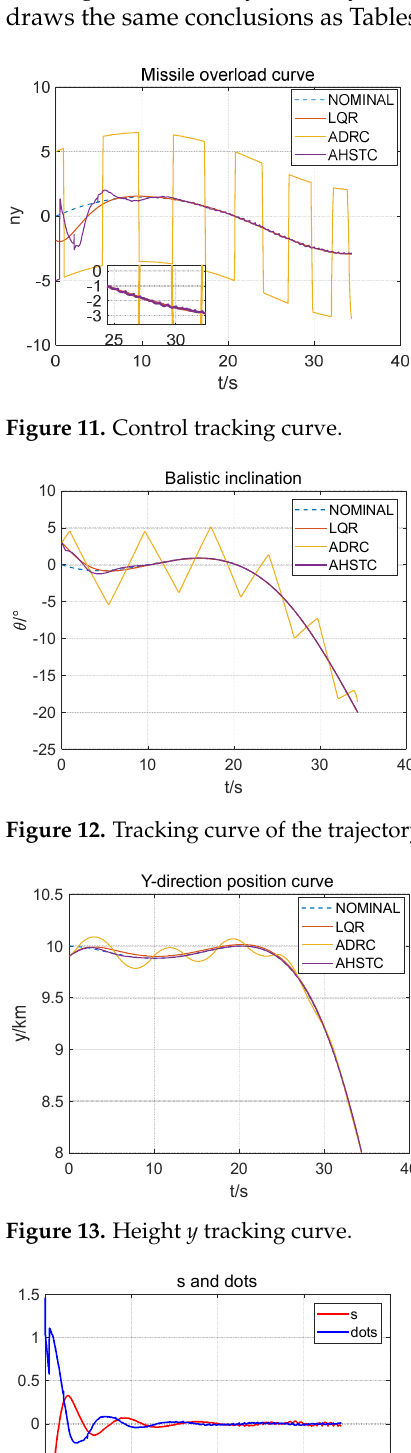
Figure 10. Trajectory tracking curve.